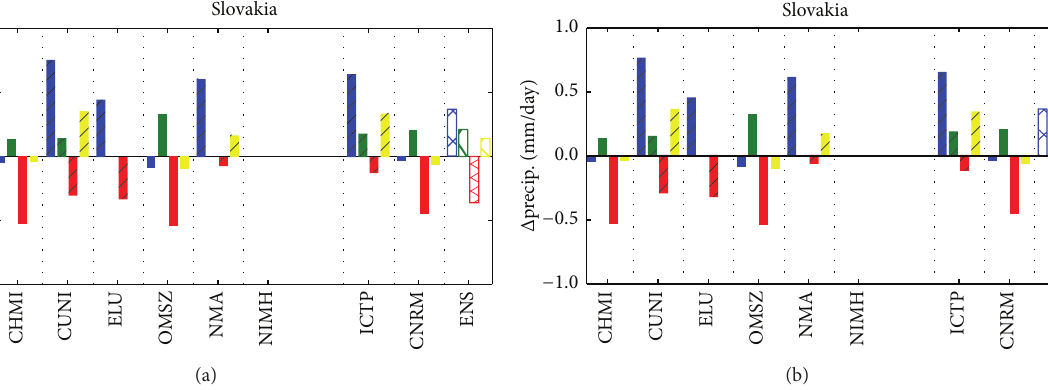
Figure 11: As Figure 10 for Slovakia.